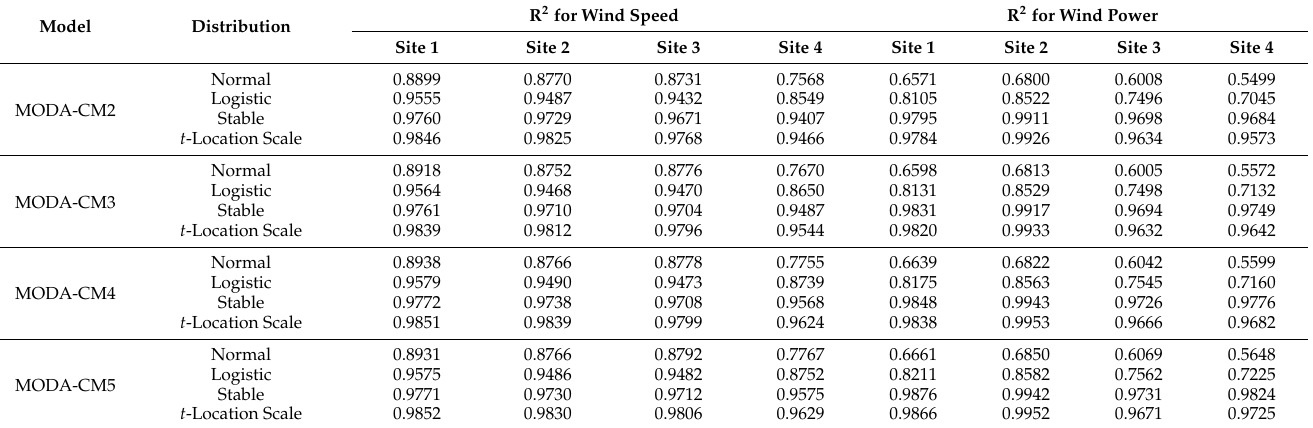
Table 9. R 2 Values of Each Distribution